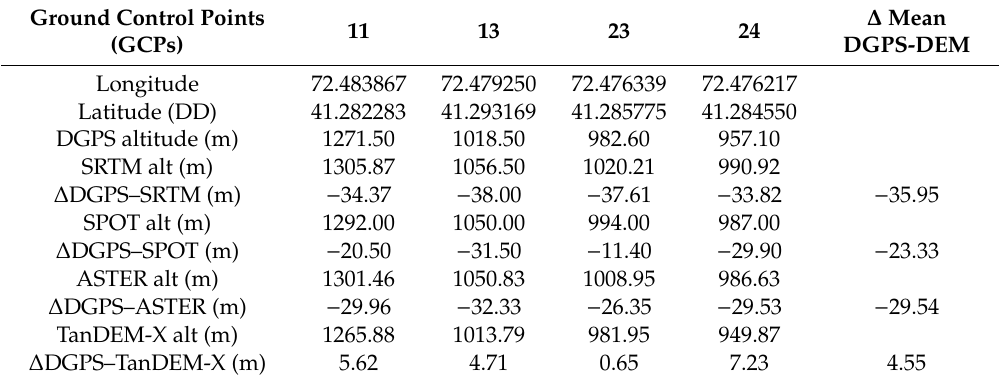
stable ground control points (GCPs) and the DEMs, and calculation of the mean di ff